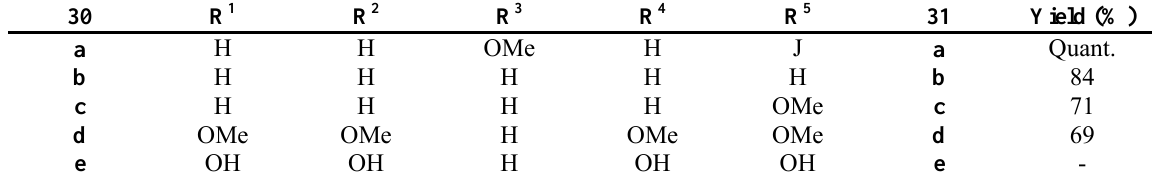
Scheme 13. 3-OMe-group prevention of the rearrangement to an inandione.